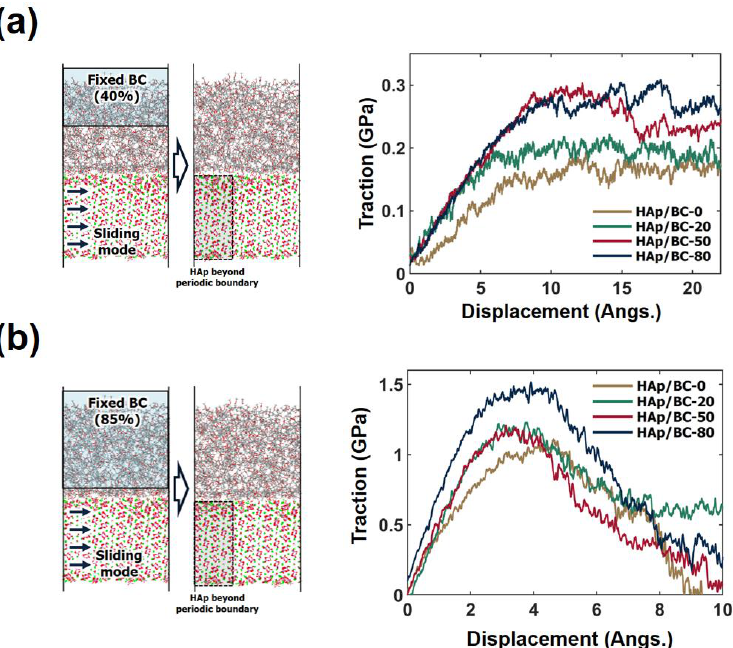
Table 5. Parameters of the interface separation (i.e., 85% of the BC constraint), for the sliding-mode test.